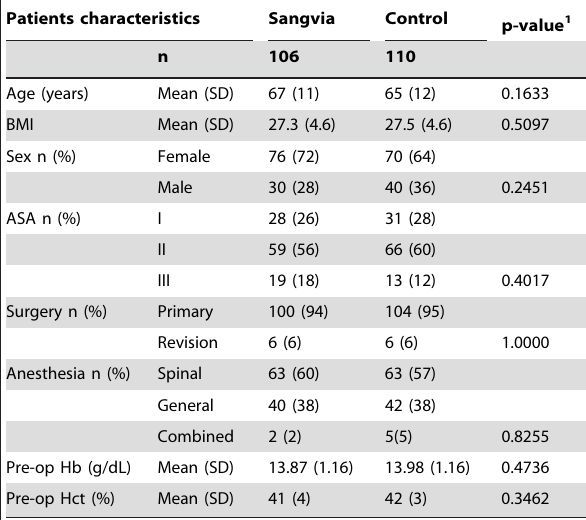
Table 1. Patients characteristics. Table 2. Estimated and calculated blood loss per treatment